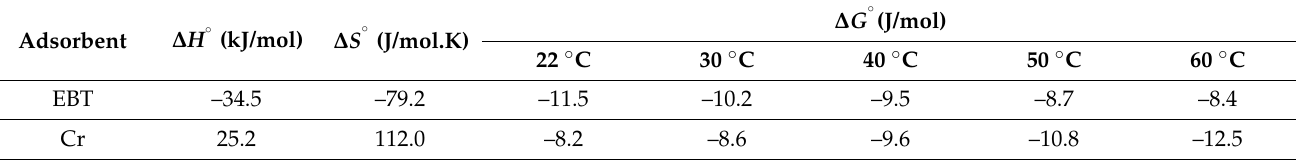
Table 6. Adsorption thermodynamic parameters of EBT and Cr removal by Mg-Ca-Al- LDO